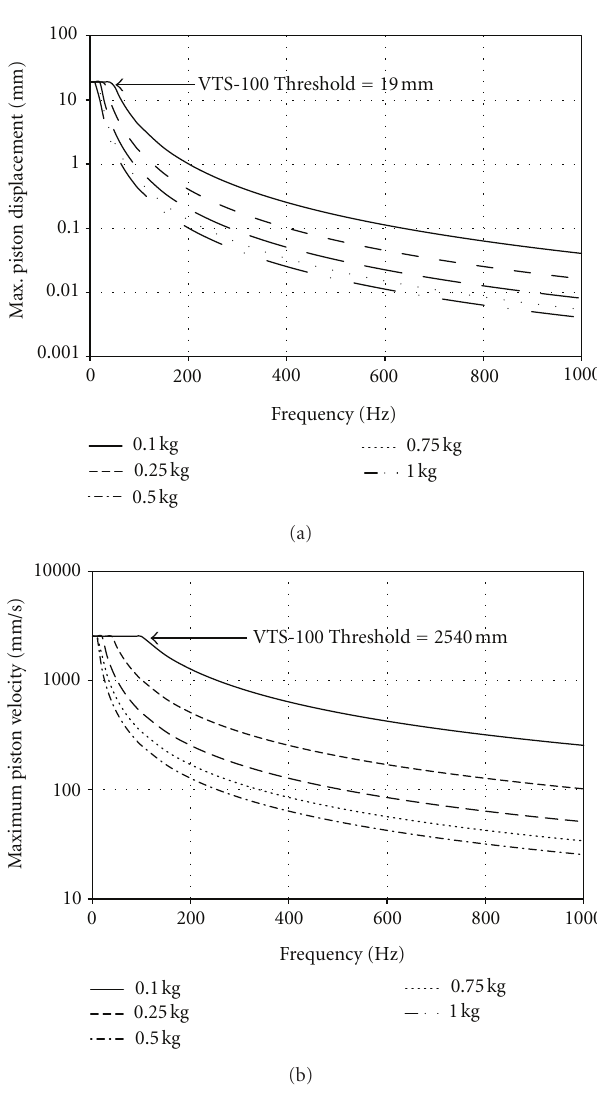
Figure 8: Dynamic properties of a system powered by an elec- tromagnetic shaker, with a sample and piston diameter of 1cm and a maximum fluid pressure of 2 MPa. (a) Maximum piston displacement as a function of frequency and driven mass. (b) Maximum piston velocity as a function of frequency and driven